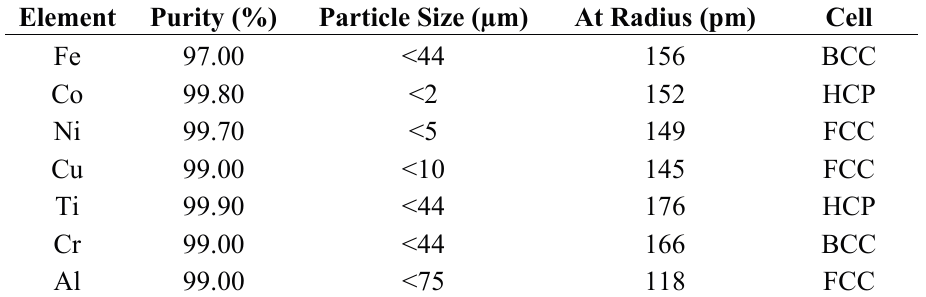
Table 1. Composition of the metal powders used (BCC = body centered cubic; FCC = face centered cubic; HCP = Hexagonal close-packed